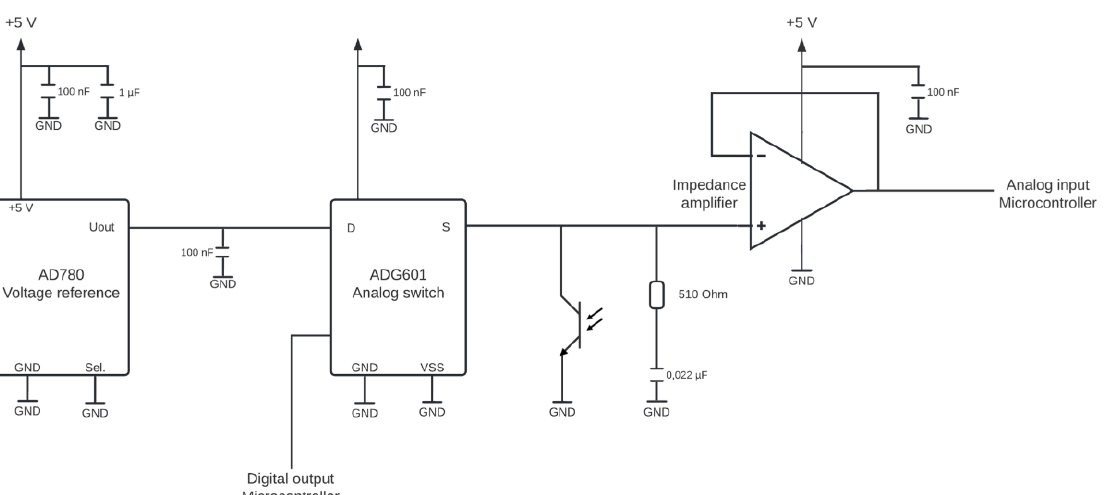
Figure 3. Measurement-circuit of the Portuino; reference voltage is connected to the 5 V pin of the Arduino to obtain a constant voltage supply of 3 V. An analog switch is used to turn the voltage on and off for the rest of the circuit. It is controlled by an analog pin of the Arduino. A phototransistor and a capacitor are connected to the analog switch. The voltage can be read out by an analog pin of the Arduino. To avoid current to flow through the analog pin, an impedance amplifier is connected.